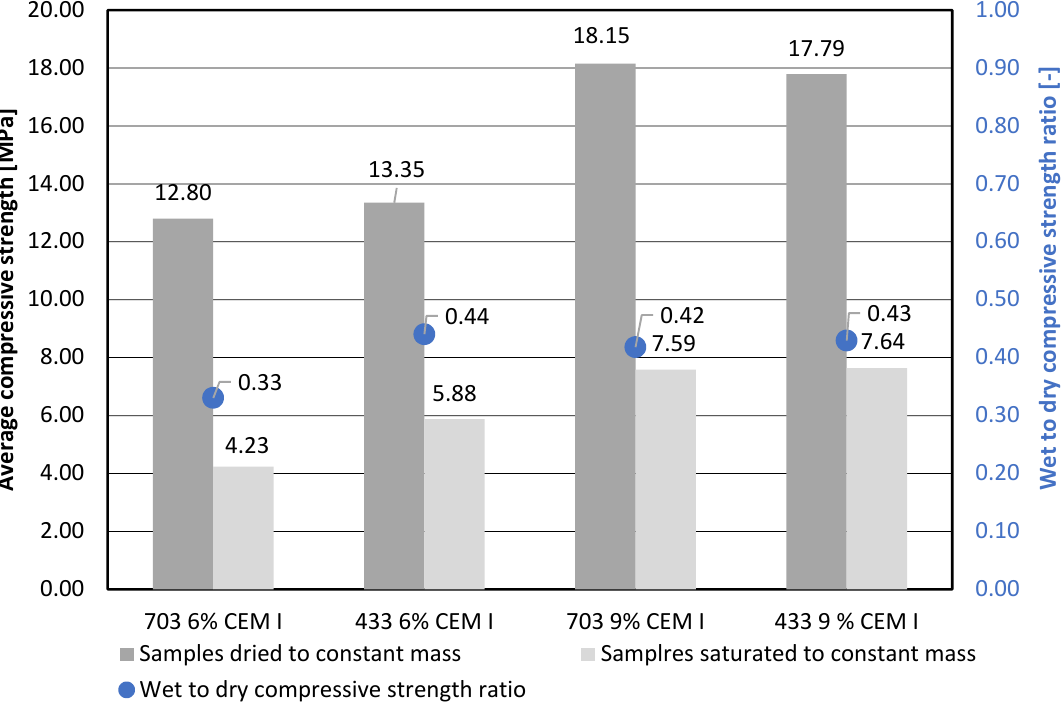
Figure 10. Average values of compressive strength of samples dried to a constant mass and completely